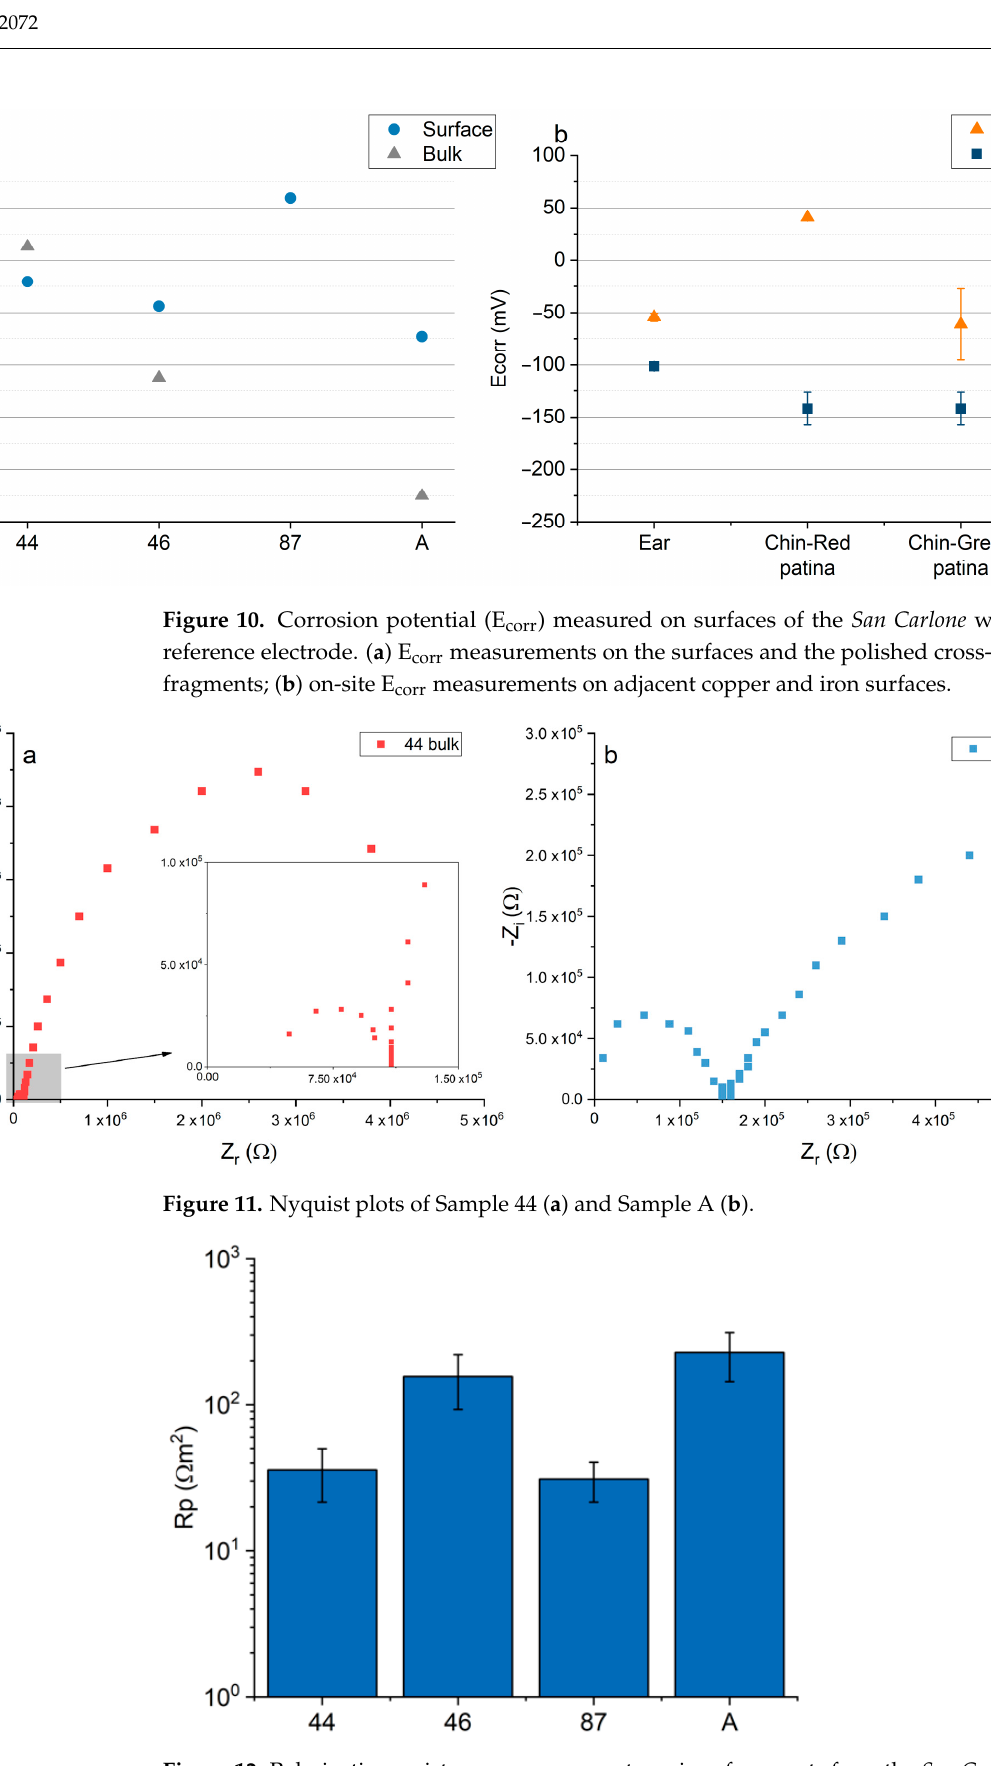
Figure 13. In situ polarization resistance measurements on iron elements of the San Carlone of Arona. Recently, oxygen depletion measurements [48] allowed for the classification of iron objects cared for by the English Heritage into four categories of corrosion behaviour. Surprisingly, a high number of objects were classified into Category 1 or 2. Particularly, Category 1 is related to a material that does not appear to deteriorate even up to very high RH values. Some sites reached 85% RH, but no sign of deterioration has been ob- served visually over 20 years of exposure. These observations are confirmed by oxygen testing of representative samples that show no detectable deterioration at 75% RH. No